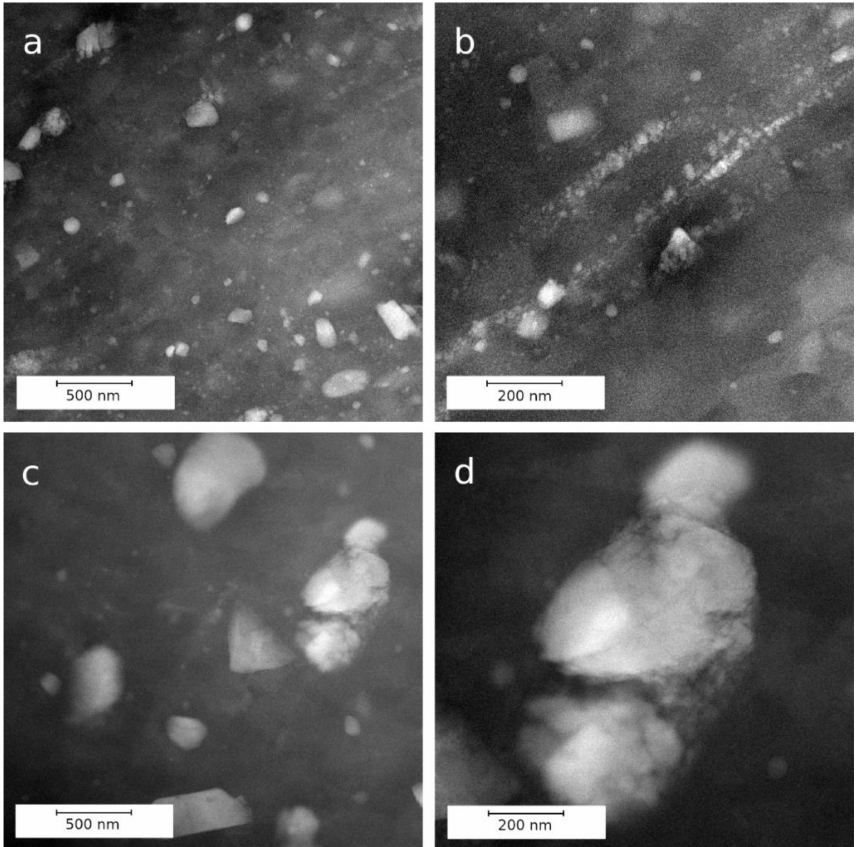
Figure 4. STEM HAADF images, obtained from the samples of the Al-2Fe alloy ( a , b ) and Al-4Fe alloy ( c , d )